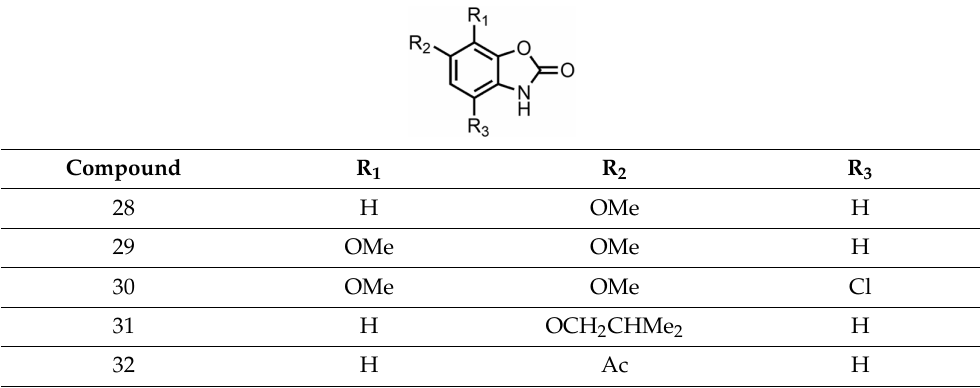
Table 3. Structure–activity relationship study of benzoxazolinones regarding auxin-induced growth and membrane-bound auxin-binding